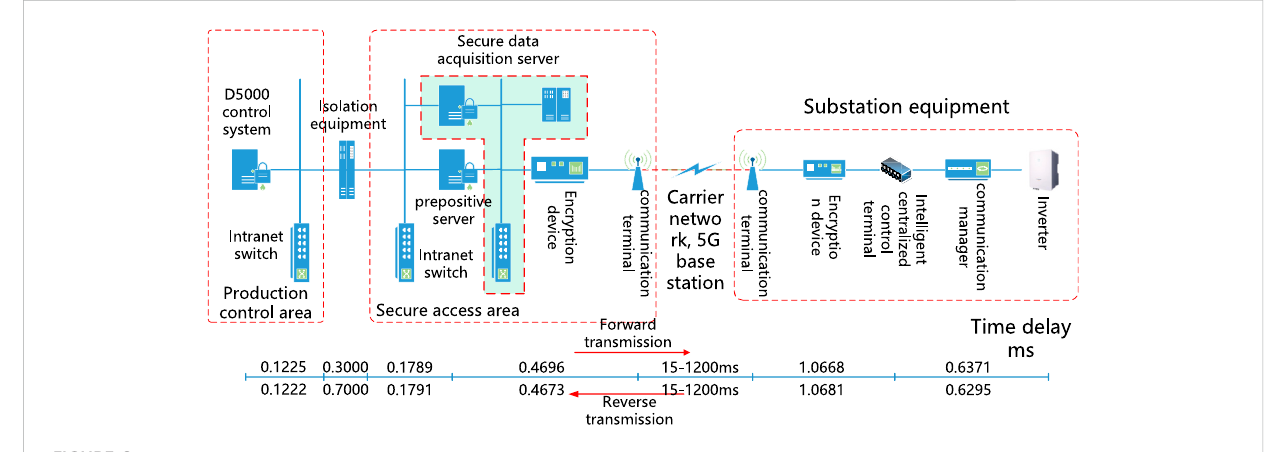
FIGURE 6 The control structure diagram and tested time delay of some practical DGs integration system.